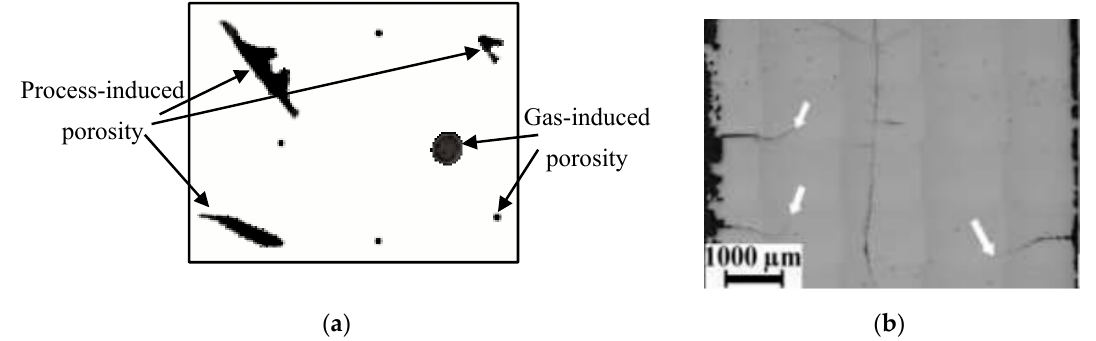
Figure 11. ( a ) Schematic representation of gas-induced and process-induced porosities; ( b ) Optical micrograph showing cracks [93].